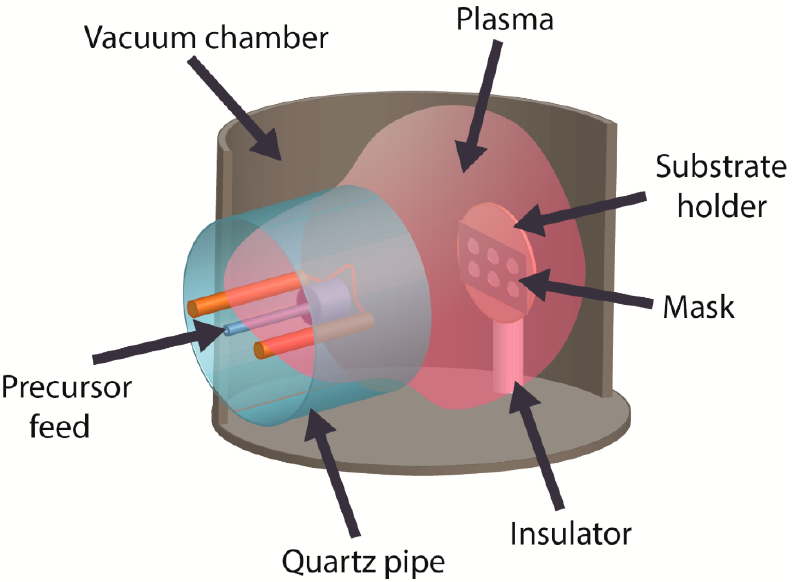
Figure 1. General configuration of the PACVD vacuum system to prepare a-C:H:SiO x films on Ti- 6Al-4V substrate.